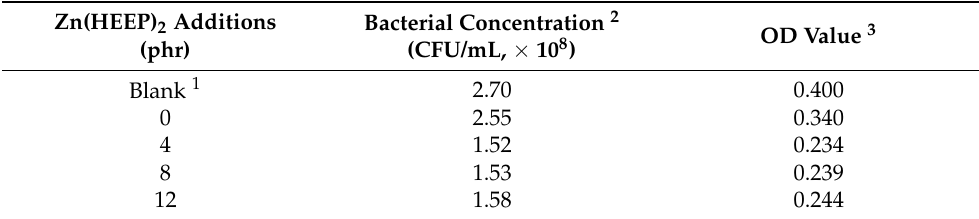
Table 1. The antibacterial activity of UV films with different Zn(HEEP) 2 additions against E. coli in the 24 h static culture